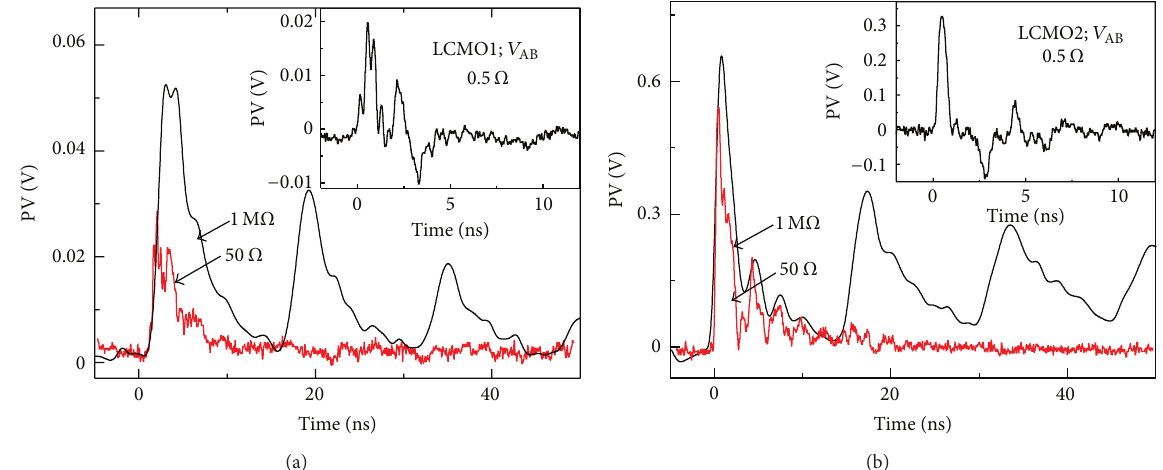
Figure 3: Photovoltaic response of (a) LCMO1 film and (b) LCMO2 film, under the illumination of a 355 nm laser pulse in duration of 25 ps along the tilted direction, recorded by an oscilloscope terminated into 1 M Ω and 50 Ω . The inset shows the photovoltaic response with a 0.5 Ω resistance which was connected in parallel with the LCMO thin